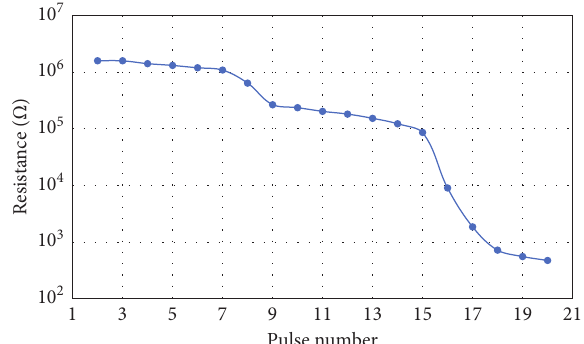
Figure 14: Pulse number vs. resistance curve of simulation 5.